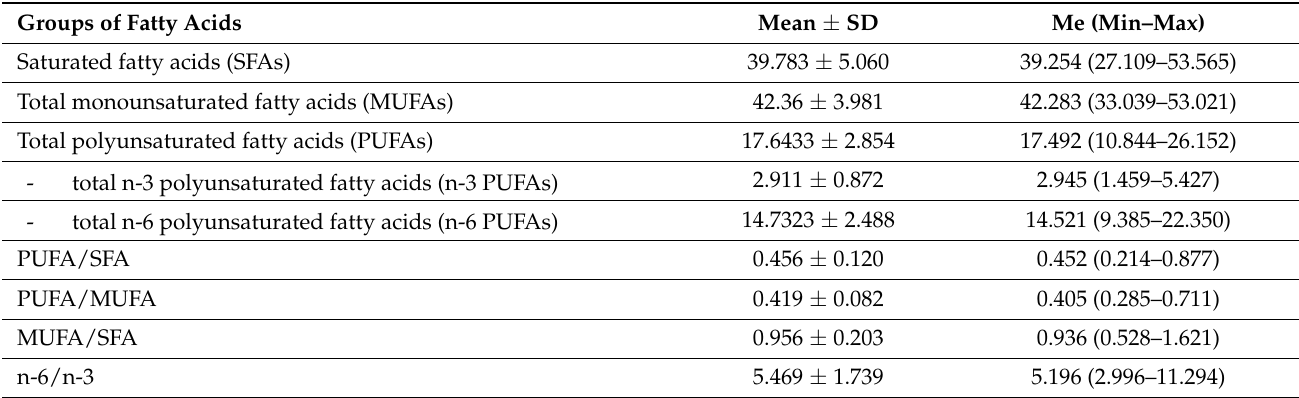
Table 4. Groups of fatty acids (g/100 g of total